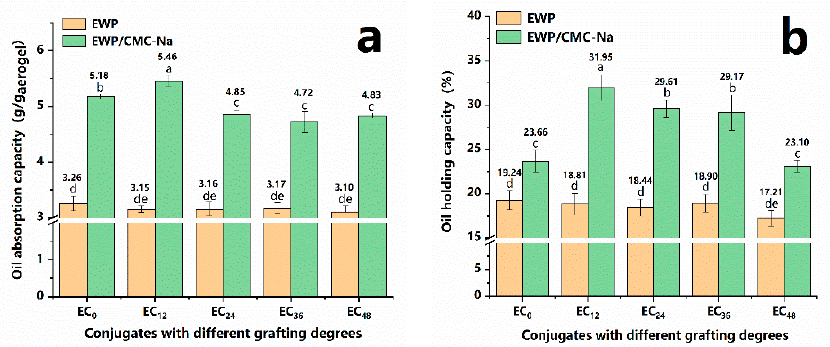
Figure 5. Oil absorption ( a )/holding ( b ) capacity of the aerogels with different grafting degrees.